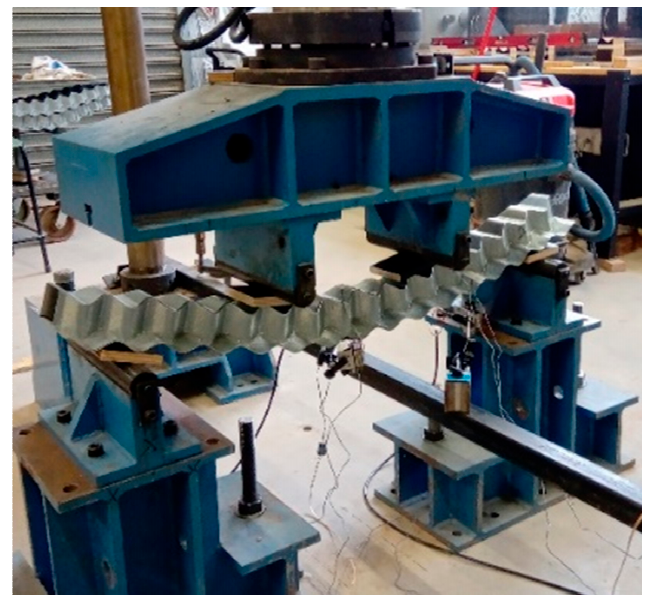
Figure 11. Failed top-hat section.